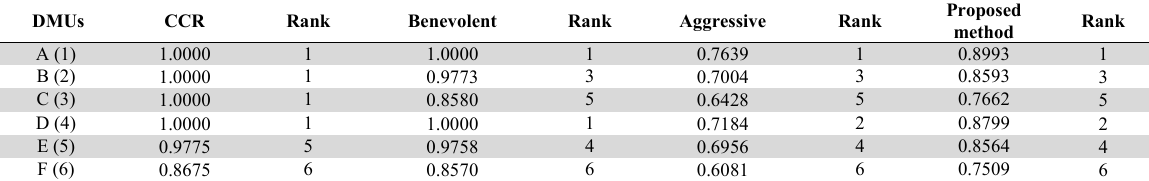
The ranking of DMUs for six nursing homes DMUs